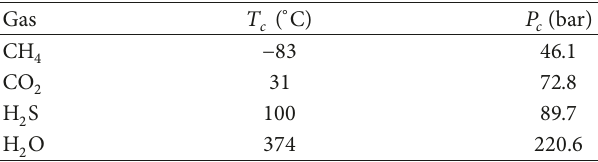
Table 1: Critical parameters of gases of